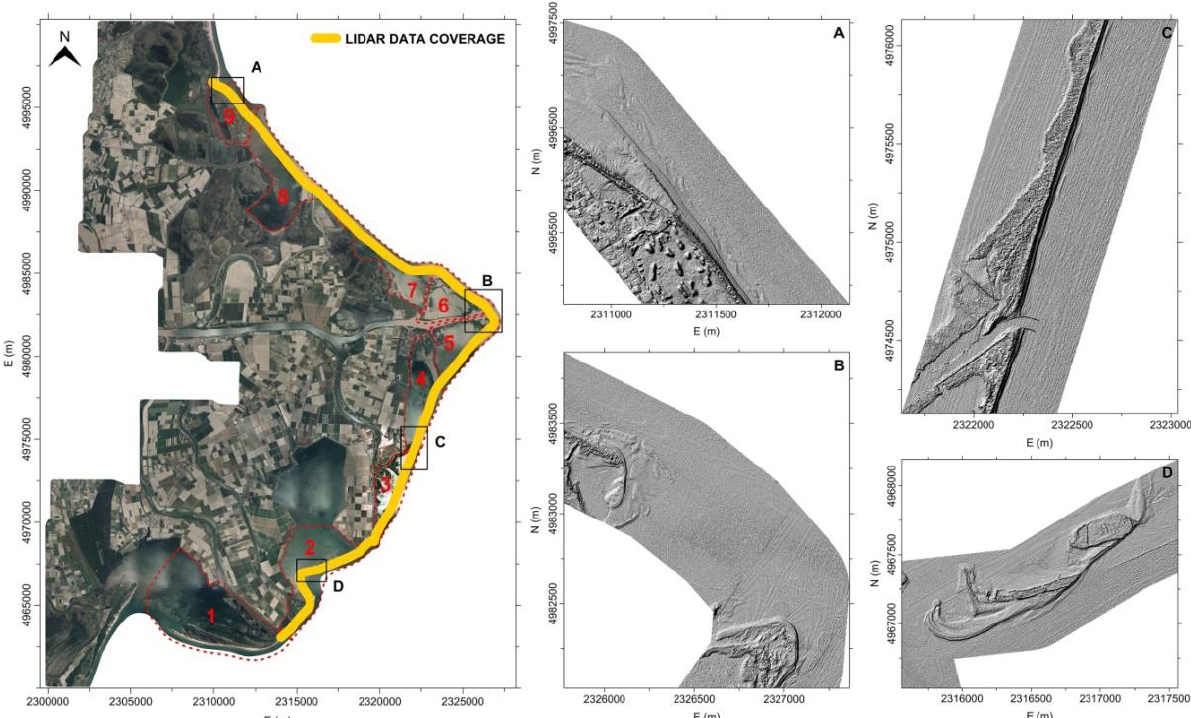
Figure 9. Coverage of the 2006 DTM from LiDAR data (last return laser beam together with procedures for objects/vegetation filtering, gridded with regular size of 1 m) and shaded relief visualization of some details ( A – D ) in PRD coastal area, outside the levees.